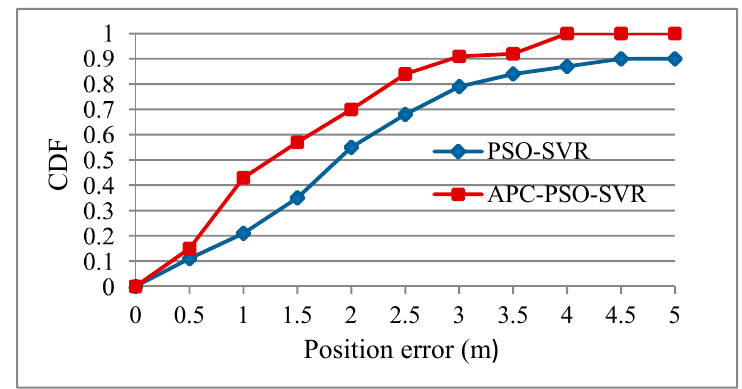
Figure 8. CDF before and after clustering.